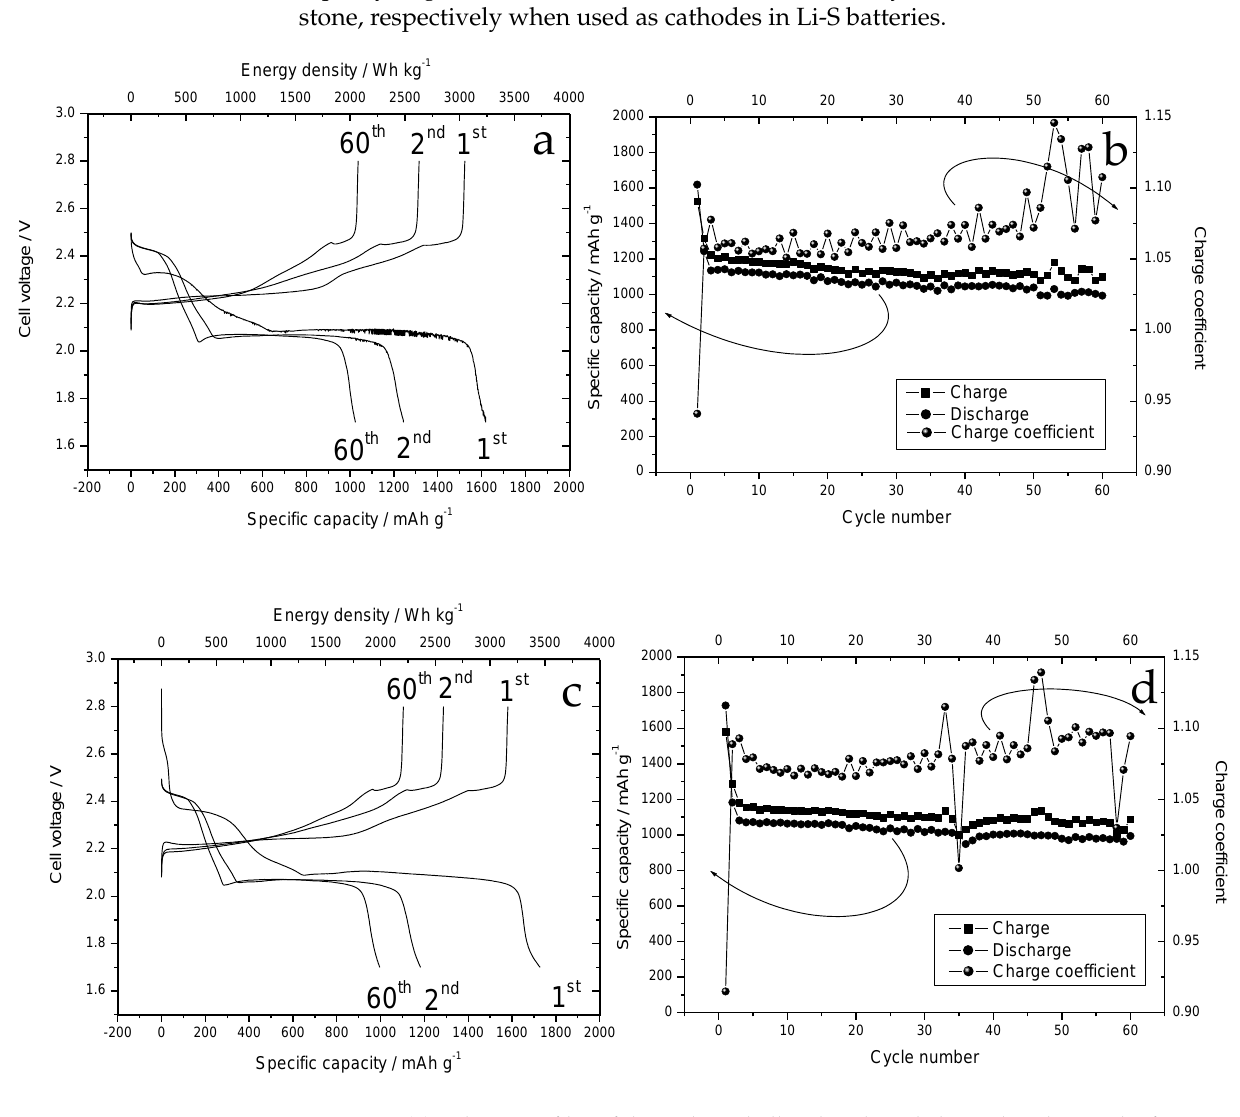
Figure 10. ( a ) Voltage profiles of the walnut shell carbon-based electrodes, during the first 60 cycles conducted at a constant current. ( b ) Variation of the specific capacity, energy density, and charge coefficient as a function of the number of cycles. The electrode load was 4.5 mg. ( c ) Voltage profiles of the cherry stone carbon-based electrodes. ( d ) Variation of the specific capacity, energy density, and charge coefficient as a function of the number of cycles. Lithium metal was used as counter and reference electrode. The electrode load was 4.1 mg. The specific capacity and the energy density were calculated on the weight of the polysulfide in the electrolyte. Cycling was carried out at a constant current between 1.70 and 2.80 V. Both the electrodes were characterized by the typical charging plateaus of Li-S batteries. The two distinct plateaus were centered at 2.4 and 2.0 V in discharge, while during the charge the plateaus moved up to 2.2 and 2.4 V, corresponding to the oxidation of Li 2 S 4 , the main redox intermediate present in the TEGDME solution. The electrode prepared with the carbon obtained from the pyrolysis of walnut shells showed an initial specific capacity at the first cycle of about 1600 mAhg − 1 . In the next charge, the electrode was capable of recharging only 1500 mAhg − 1 . Capacity rapidly decreased to 1250 mAhg − 1 during the second discharge and then dropped to 1150 mAhg − 1 in the next cycle. In subsequent